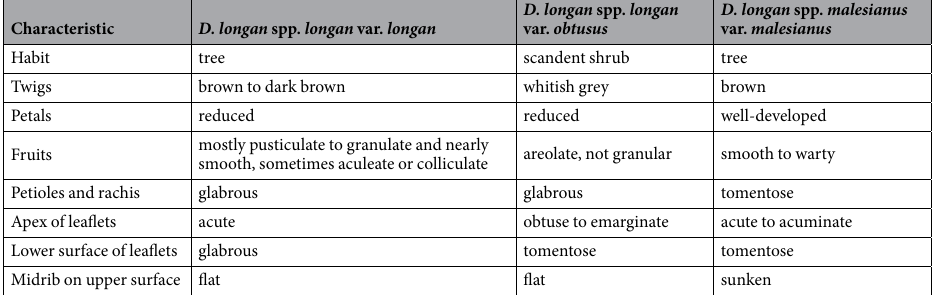
Table 1. The morphological characteristic comparison of 3 varieties of Dimocarpus longan 2, 5, 6